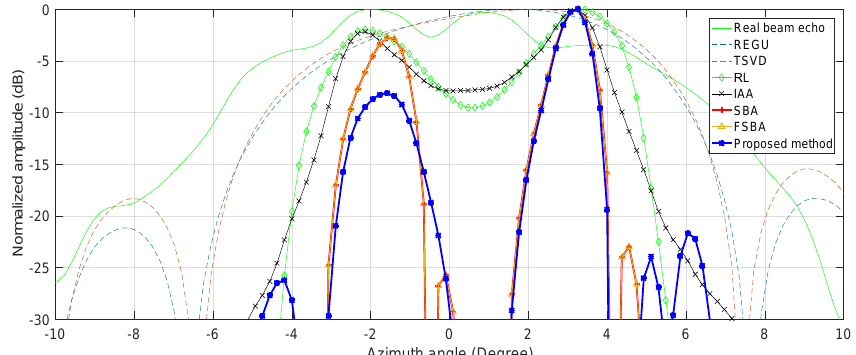
Figure 8. Profiles of local region in Figure 7.